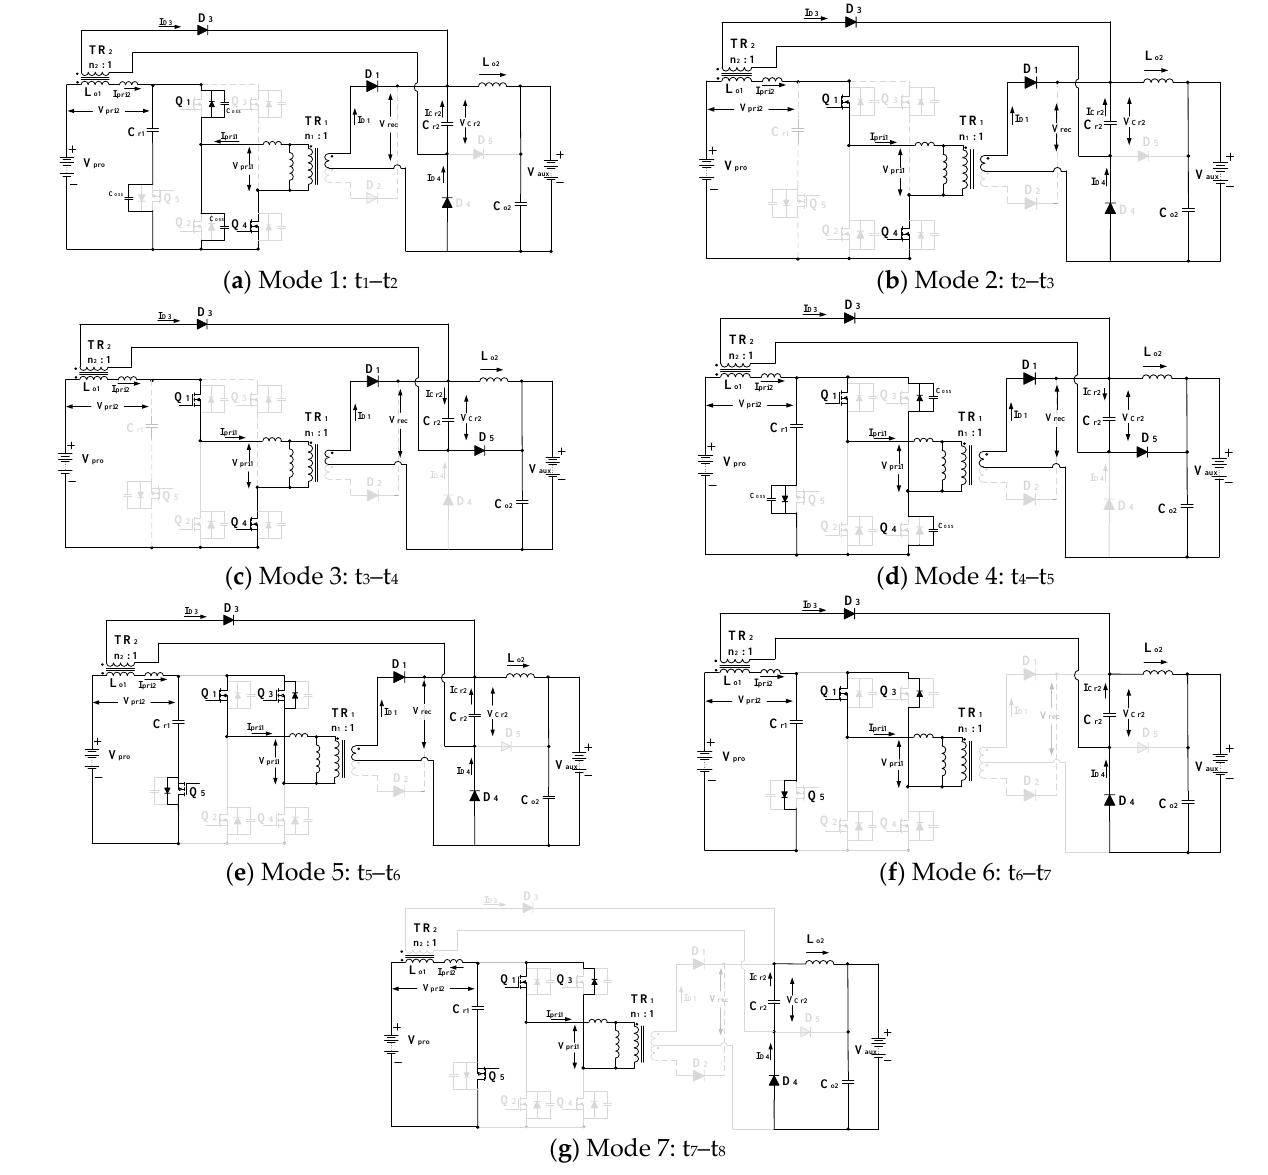
Figure 4. Equivalent circuits of proposed LDC converter.